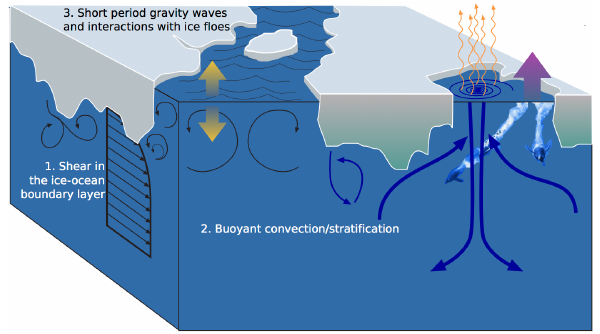
9 Figure 1. A graphic illustration of three mechanisms that can lead to turbulence production and 10 Fig. 1. A graphic illustration of three mechanisms that can lead to gas exchange in the ice-ocean boundary layer. 11 turbulence production and gas exchange in the ice–ocean boundary